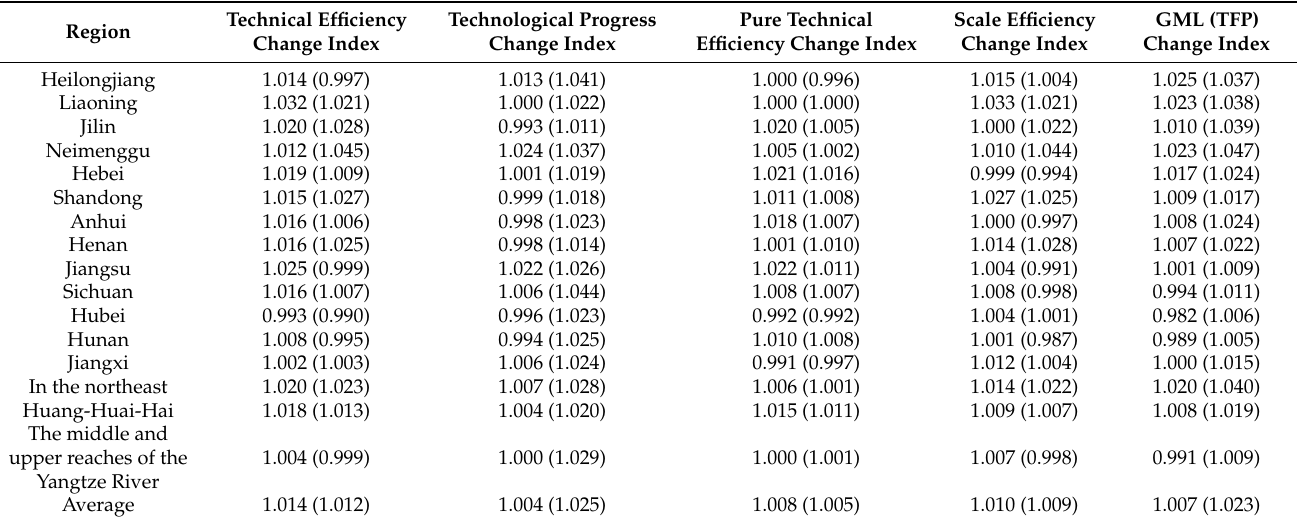
Table 6. Dynamic change index of total factor productivity of grain production resources in the major producing areas from 2000 to 2019.